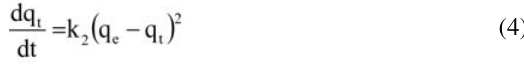
Fig. 5. Effect of different pretreatments on the Cu 2+ uptake of waste brewery yeast biomass; C °C, pH 4.6, 150